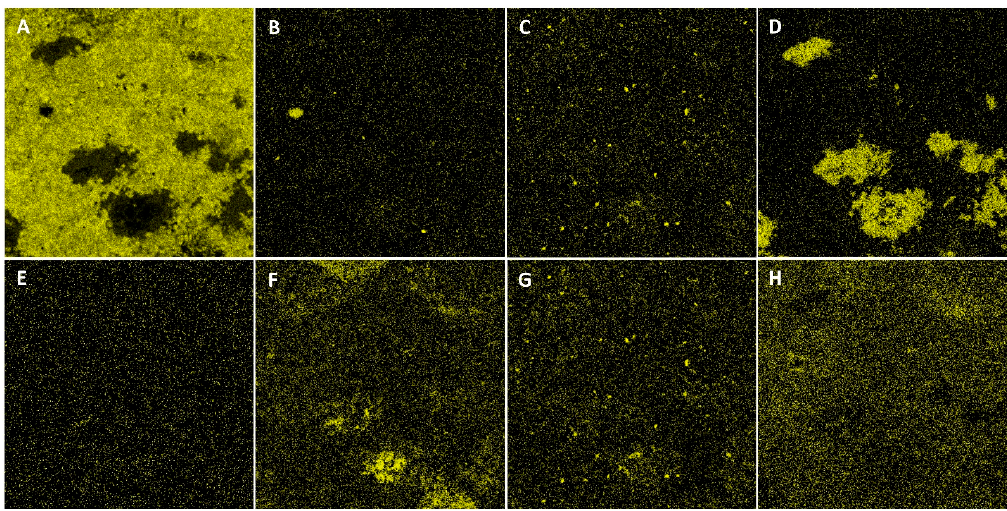
Figure 6. SEM-EDS elemental distribution maps for aluminum ( A ), silicon ( B ), molybdenum ( C ), copper ( D ), zinc ( E ), tin ( F ), lead ( G ) and magnesium ( H ) for M3 alloy.